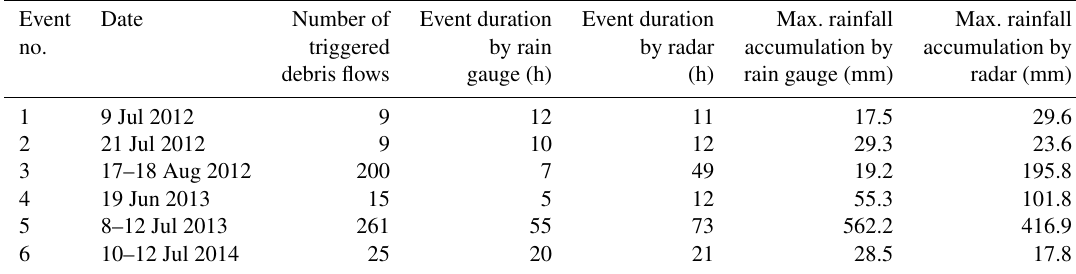
Figure 7. Images of radar-estimated rainfall accumulation for the six rainfall events (a–f) . Circles represent the location of triggered debris flows. Events are shown in chronological order: (a) 9 July 2012; (b) 21 July 2012; (c) 17–18 August 2012; (d) 19 June 2013; (e) 8– 12 July 2013; (f) 10, 12 July 2014. Table 2. Characteristics of the rainfall events. Event Date Number of Event duration Event duration Max. rainfall Max.